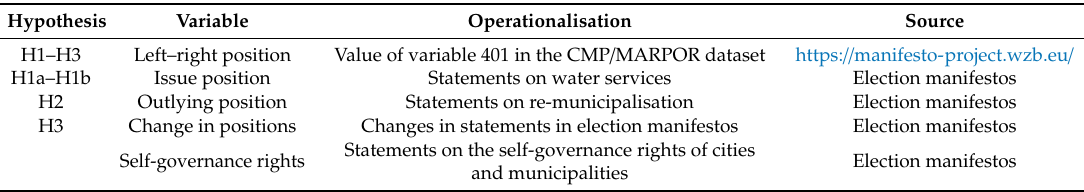
Table 2. Operationalisation of the